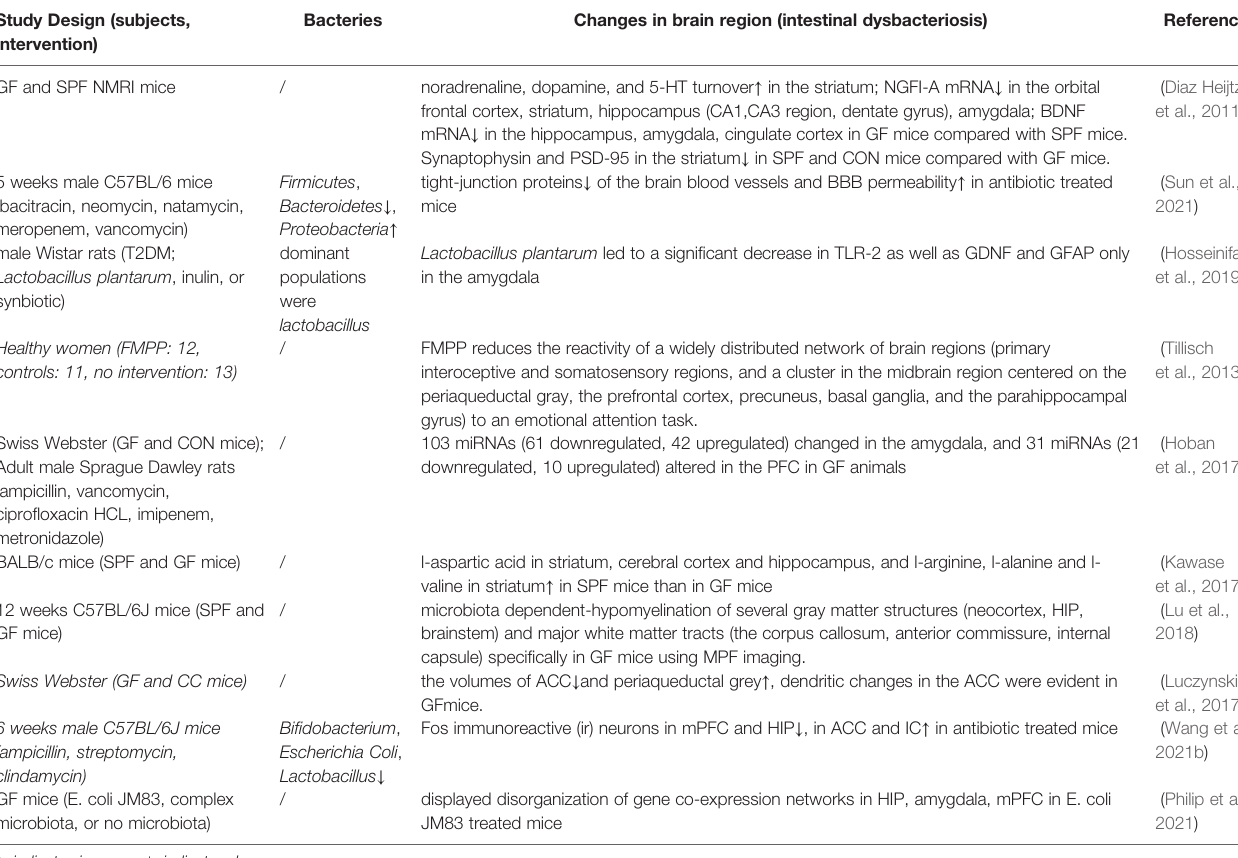
TABLE 3 | The studies associated with changes in brain regions and gut microbiota. Study Design (subjects,